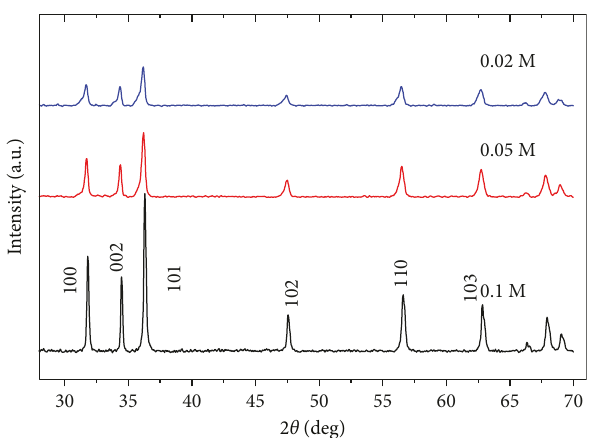
Figure 1: X-ray diffraction patterns of ZnO nanoparticles when varying zinc acetate